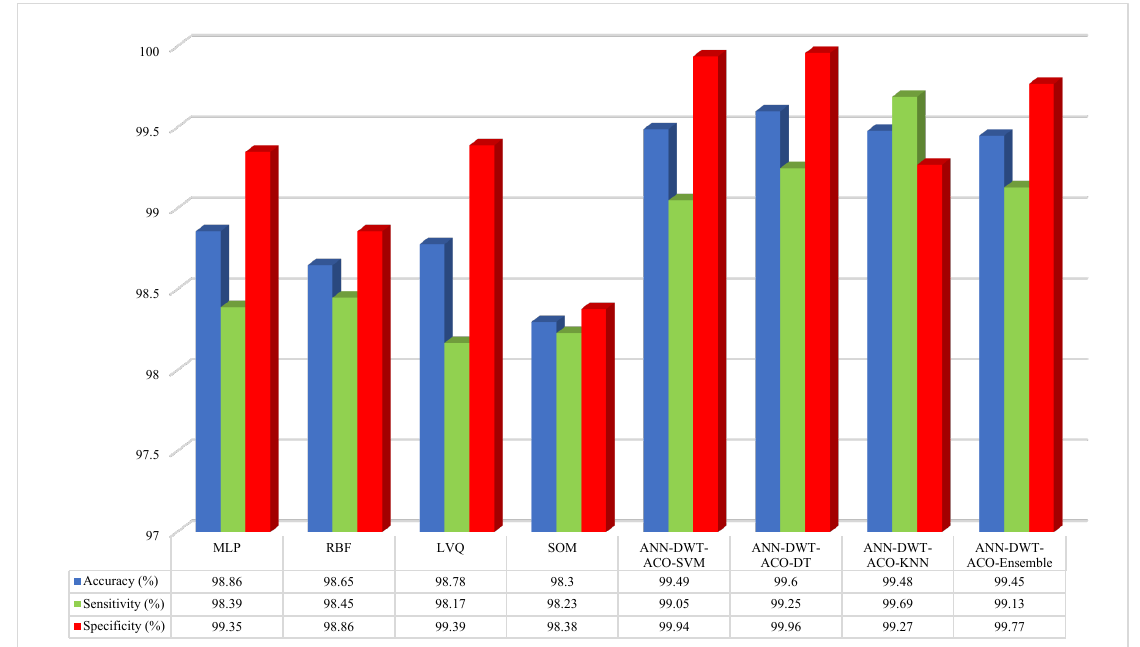
Figure 10. Graphical illustration of the accuracy, sensitivity, and specificity.